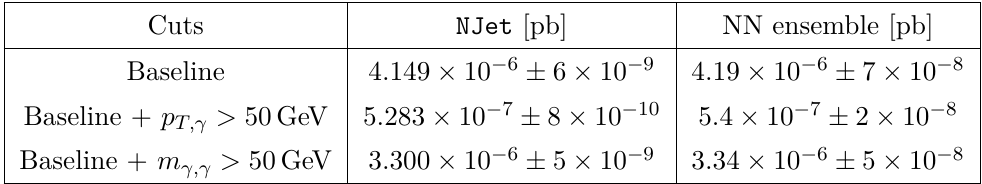
Table 1. Cross-sectional comparison between NJet and the NN ensemble approach using different cuts. Baseline cuts are those specified at the beginning of section 4. The NJet results are quoted with MC errors and the NN ensemble results with precision/optimality uncertainties calculated as described in ref.